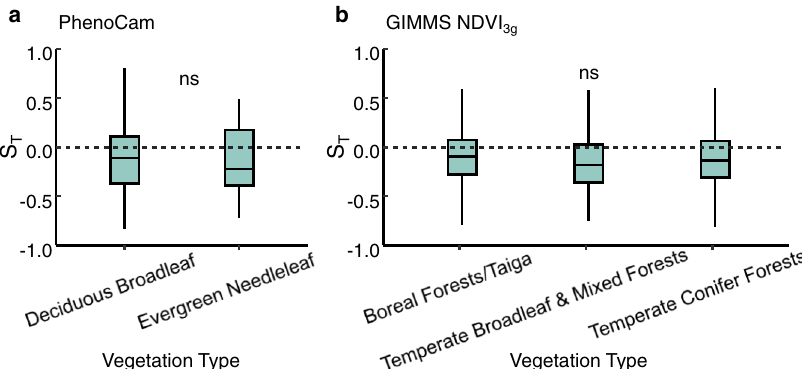
Fig. 3 Temperature sensitivities (S T , change in days per degree Celsius) of start of season (SOS) in current year in response to increasing temperature during previous growing season. a The S T based upon PhenoCam data in deciduous broadleaf and evergreen needleleaf forests. b The S T based upon GIMMS NDVI3g data in boreal and temperate forests. The black dash lines indicate when S T equals zero. In the box plots, the box spans from the fi rst to the third quartile and the median is marked as the black line. One-way analysis of variance (ANOVA) followed by Tukey ’ s honestly signi fi cant difference (HSD) test was used to test the differences in the S T between vegetation types, and two-sided test was used to calculate P values, the “ ns ” means no signi fi cant difference between groups ( P > 0.05). The sample size and calculated P values were listed in Supplementary Tables 2,